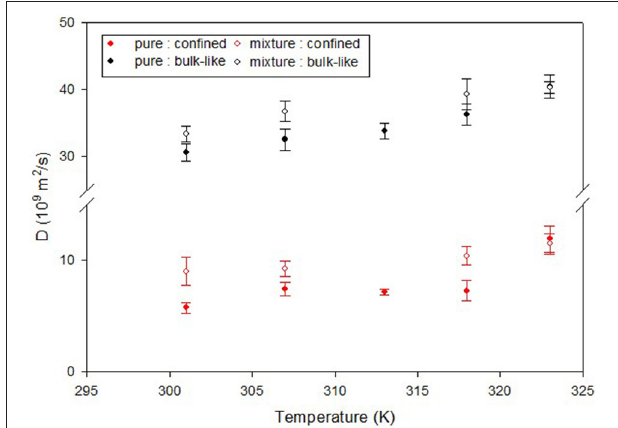
FIGURE 7 | Diffusion coefficient of ethane in CPG silica with 7.5 nm pores obtained from a QENS study. Two populations of ethane molecules were found that contributed to the quasielastic width—a bulk like population (black symbols) and another population that exhibited reduced mobility due to confinement (red symbols). The effect of CO 2 can be seen as an enhancement of the diffusivity of ethane in presence of CO 2 (open symbols) compared to that in the absence of CO 2 (solid symbols). Reprinted with permission from Patankar et al. (2016), Copyright 2016 American Chemical